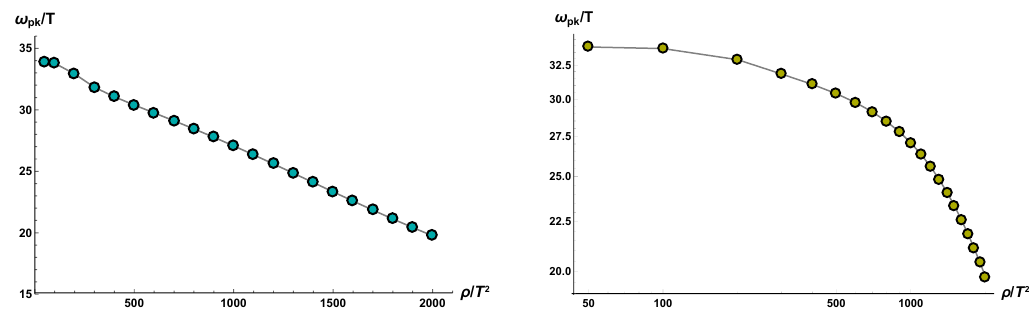
Figure 23 . Left: Dependence of the peak position ! pk as a function of the charge density (cid:26)=T 2 . The peak is extracted from the real part of the longitudinal conductivity. Right: A log-log plot for ! pk